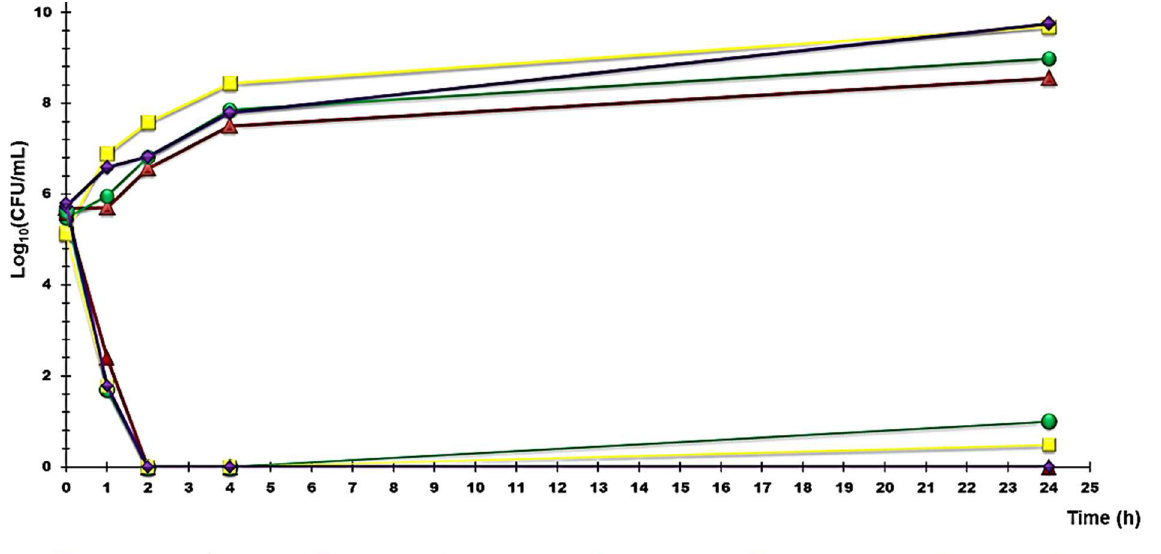
Figure 2. Time-killing curves performed with CR232-G5K NPs (at concentrations equal to 4 x MIC) on P. aeruginosa 265 and 259, E. coli 462, and S. aureus 187.